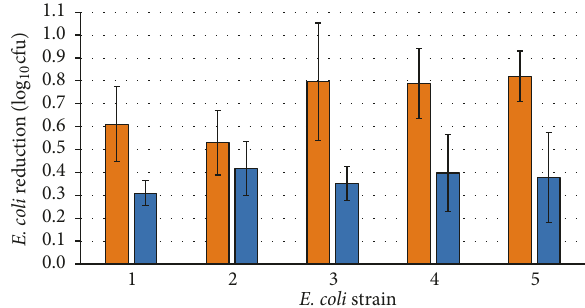
Figure 2: Reduction of E. coli in a TFS model. Salami batter with starterculturefermentedat20 ∘ Cfor21daysgivingmaturedsausages (orange bars) and meat batter controls without starter culture held at 4 ∘ C (blue bars) are shown. Isolates are numbered according